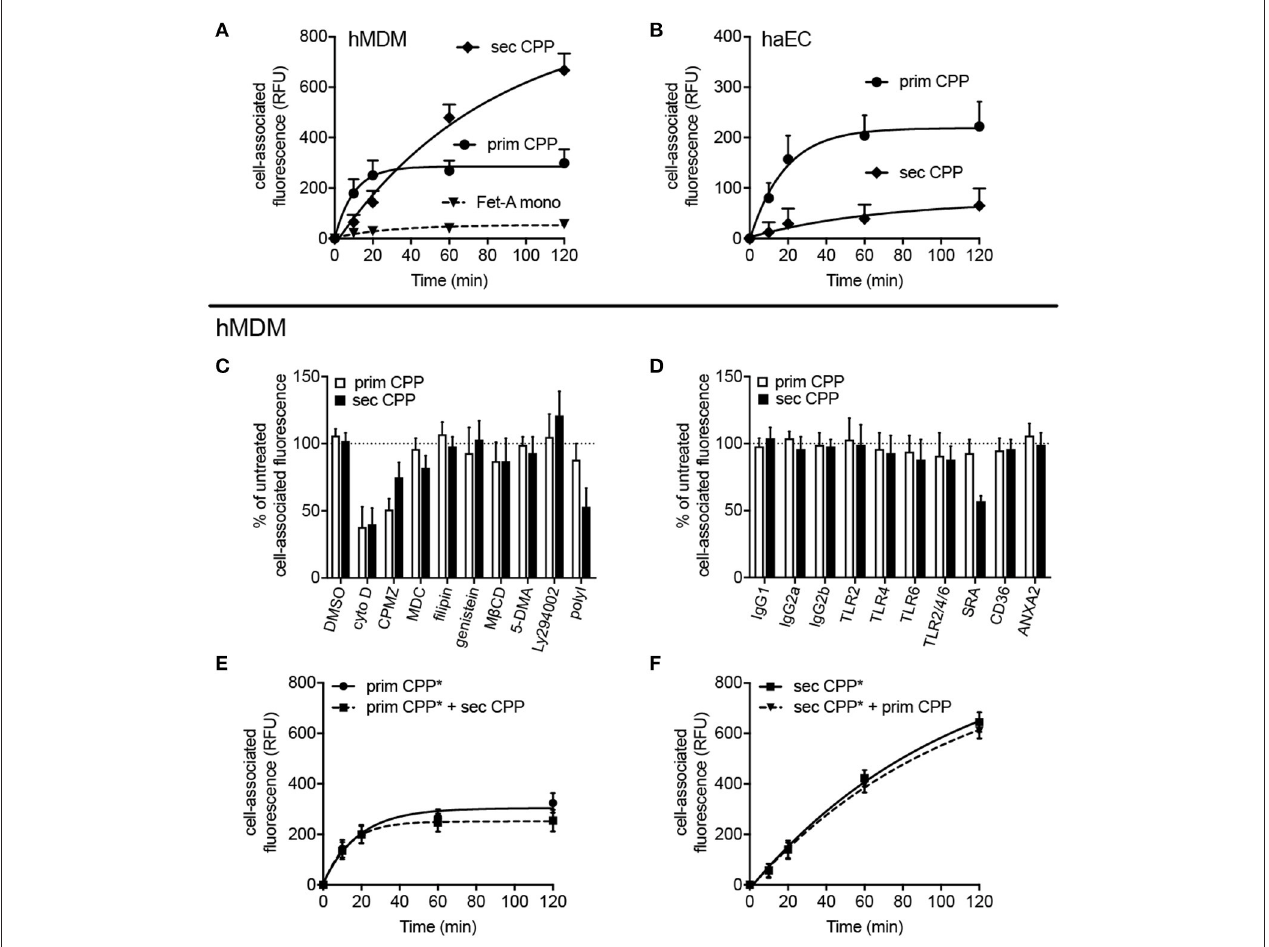
FIGURE 6 | Differential endocytosis of primary and secondary CPP in human monocyte-derived macrophages and aortic endothelial cells. Human monocyte-derived macrophages (hMDM) or human aortic endothelial cells (haEC) were treated with Alexa488-labeled primary or secondary CPP, both 100 µ g/mL calcium content, synthesized from FCS/DMEM supplemented with phosphate (final conc. 3.5mM). Monomeric labeled-fetuin-A was included as a comparator (1 mg/ml). Cell-associated fluorescence was measured by flow cytometry in fixed cells at the stated timepoints. (A) Endocyosis observed in hMDM and (B) haEC, respectively. (C,D) hMDM were pre-treated for 30–60min with one of several inhibitors (vs. vehicle) or receptor blocking antibodies (vs. isotype control). (C) Pre-treatment with cytochalasin (D) , an inhibitor of actin polymerization, markedly attenuated uptake of both primary and secondary CPP and ( < 50% untreated signal; p < 0.01) indicating the requirement for active actin-mediated cytoskeletal rearrangement for CPP internalization. Inhibition of protein tyrosine kinase/caveolin-dependent endocytosis (filipin and genestein), lipid-raft synthesis (methyl cyclodextrin- β -cyclodextrin; M β CD), macropinocytosis [5-(N,N-dimethyl)amiloride; 5-DMA], and phosphoinositol-3-kinase-dependent Fc γ receptor-mediated endocytosis (Ly294002) all had no significant effect on CPP uptake. Likewise, pre-treatment with monodansylcadaverine (MDC), an inhibitor of clathrin-mediated endocytosis had no effect on particle uptake. Inhibition of clathrin-dependent endocytosis with chlorpromazine significantly reduced primary CPP internalization ( < 50%; p < 0.05) but not secondary CPP, but may potentially reflect off-target effects due to the non-specificity of the inhibitor. (D) Specific immunochemical blockade of TLR2, TLR4, and TLR6, independently of one another, or in combination failed to